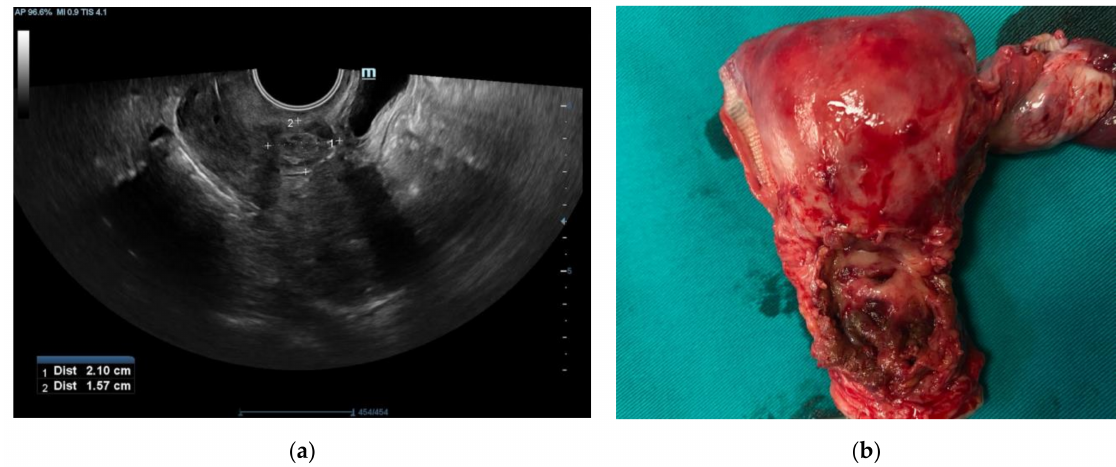
Figure 3. Immunohistochemical exam: ( a ) The sample was p63 diffusely positive; ( b ) Ki-67 nuclear labeling index of 20%.